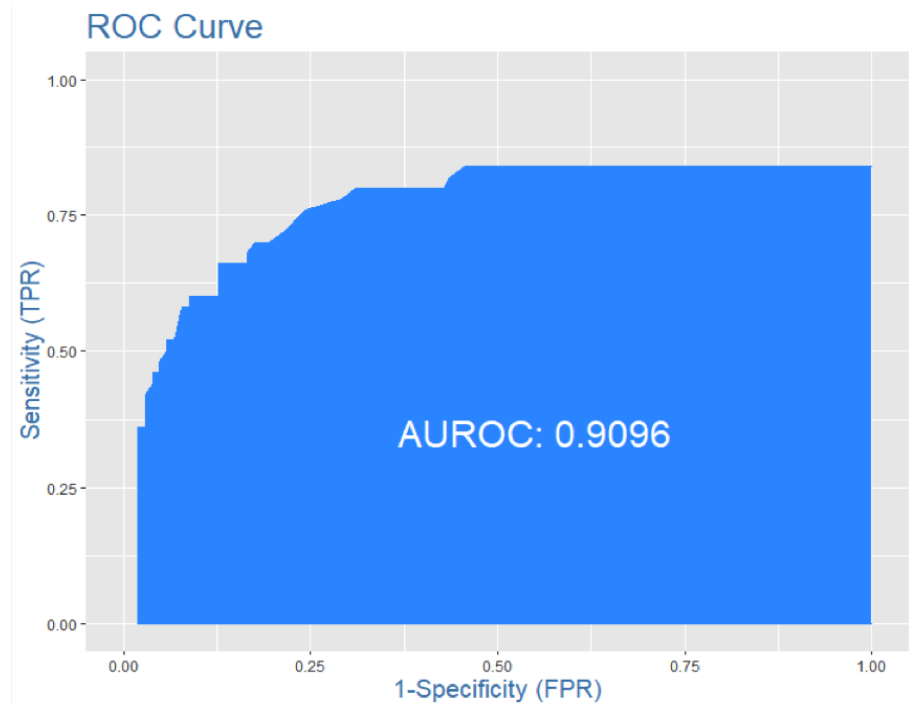
Figure 1. ROC-AUC report the high accuracy of the model in distinguishing the diagnosis of COVID-19 between the two groups.